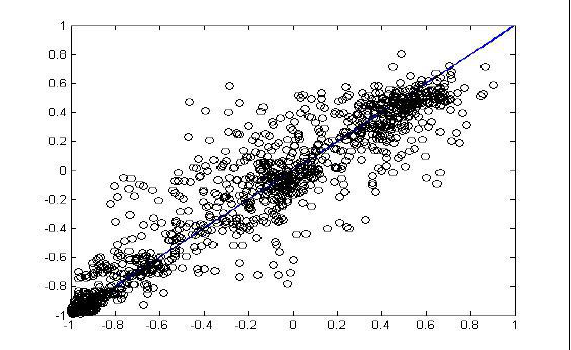
Figure12. Results of test and neural network for test data We use this neural network for prediction of the 301st day and compare it with the real number of traffic data as shown in table 1.